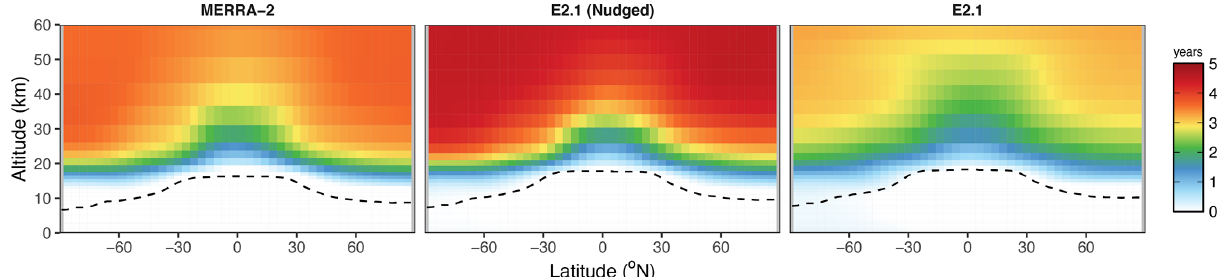
Figure 12. Average age of air in the stratosphere in GEOS-Chem simulations driven by MERRA-2, E2.1 nudged to MERRA-2, and E2.1, using the temporal lag in the simulated 2005–2014CE time series of SF 6 relative to the tropical tropopause as a chronological tracer. The dashed black line shows the simulated zonal mean tropopause